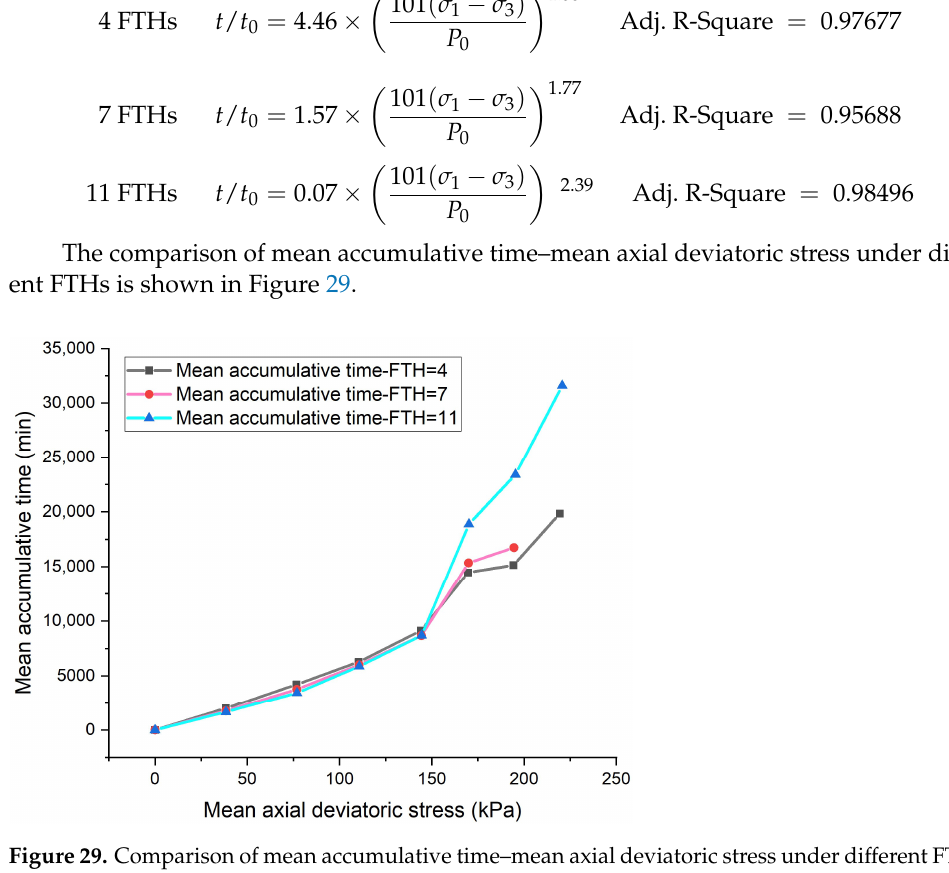
Figure 29. Comparison of mean accumulative time–mean axial deviatoric stress under different